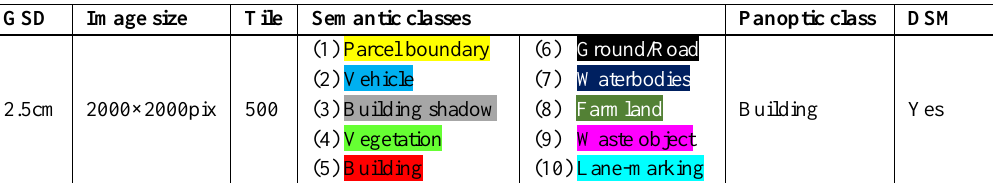
Table 2. Detail of the proposed multi-task